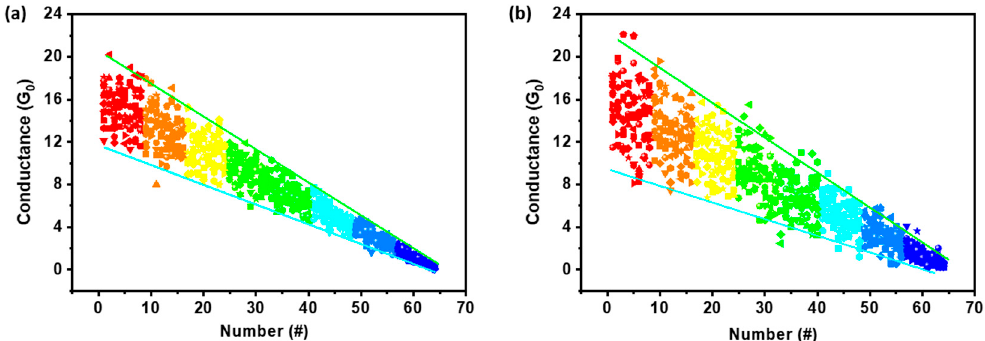
Figure 4. Mathematically simulated distribution of the device conductance in the 16 G 0 to 0.5 G 0 range with a 0.25 G 0 step for ( a ) the pre-treated Pt / HfO x / Pt memristor device sample A with microelectrode protrusion and ( b ) the untreated control device sample B with flat Pt / HfO x interface, respectively.